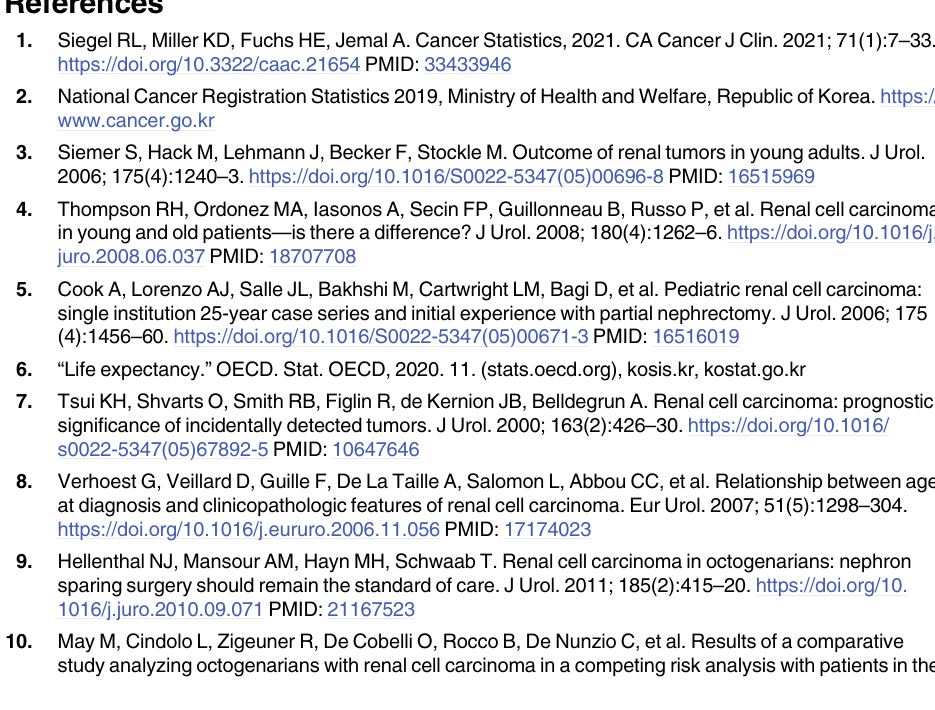
S2 Table. Multivariable Cox regression analyses for cancer-specific and other-cause mor-